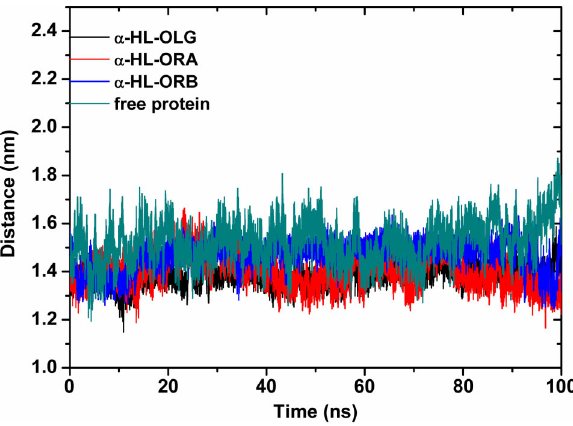
Figure 7. Plots of distances between the C a atoms of Arg104 and Asp128 tracked through MD simulation. The average distance in OLG, ORA, ORB complexes and free protein is 1.35, 1.41, 1.45 and 1.55 nm,